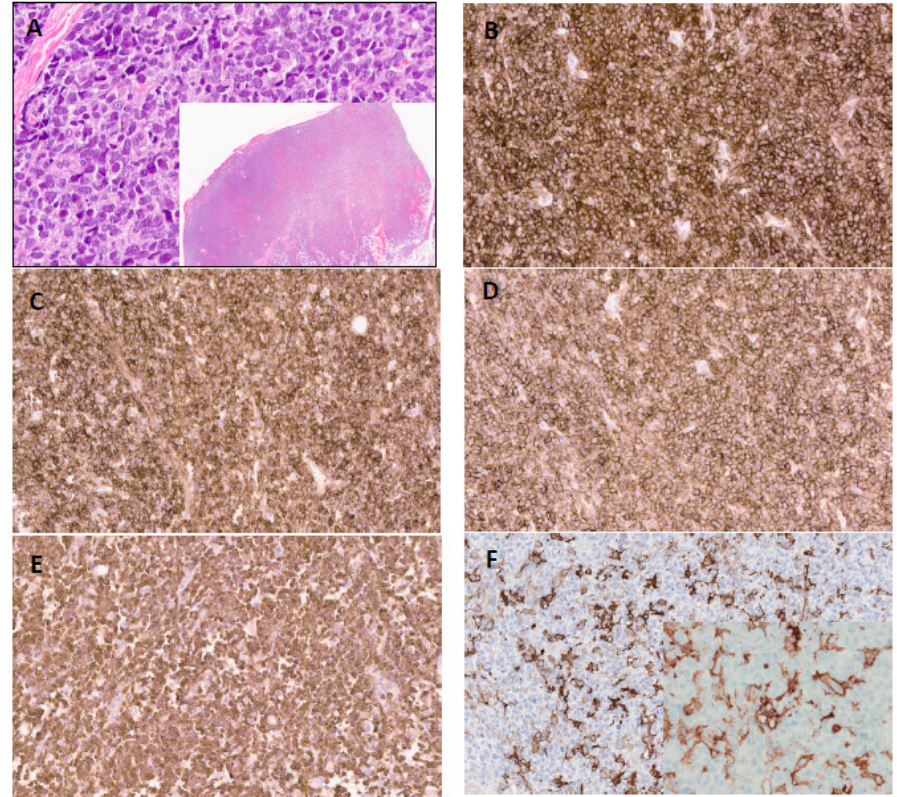
Figure 1. Excisional biopsy of cutaneous blastic plasmacytoid dendritic cell neoplasm lesion. Representative hematoxylin and eosin sections (high power × 200 and inset; low power × 30) ( A ) and immunohistochemical staining ( × 200) showing expression of CD4 ( B ), CD123 ( C ), CD56 ( D ), and TCL1 ( E ). Immunohistochemistry for and PD-L1 demonstrated partial to complete membranous staining with strong (3 + ) intensity (200x; inset 400 × ) in 55% of tumor cells ( F ).